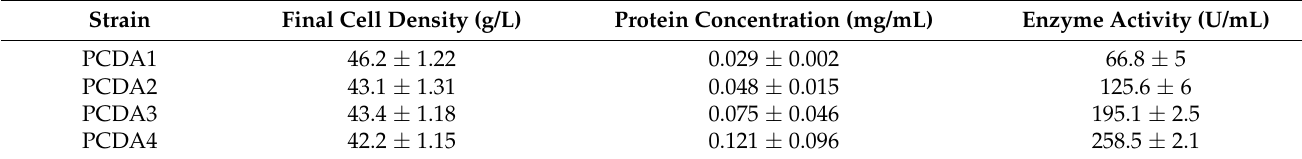
Table 1. Comparisons of the enzyme activity of PCDA1, PCDA2, PCDA3, and PCDA4. Strain Final Cell Density (g/L) Protein Concentration (mg/mL) Enzyme Activity (U/mL) PCDA1 46.2 ±